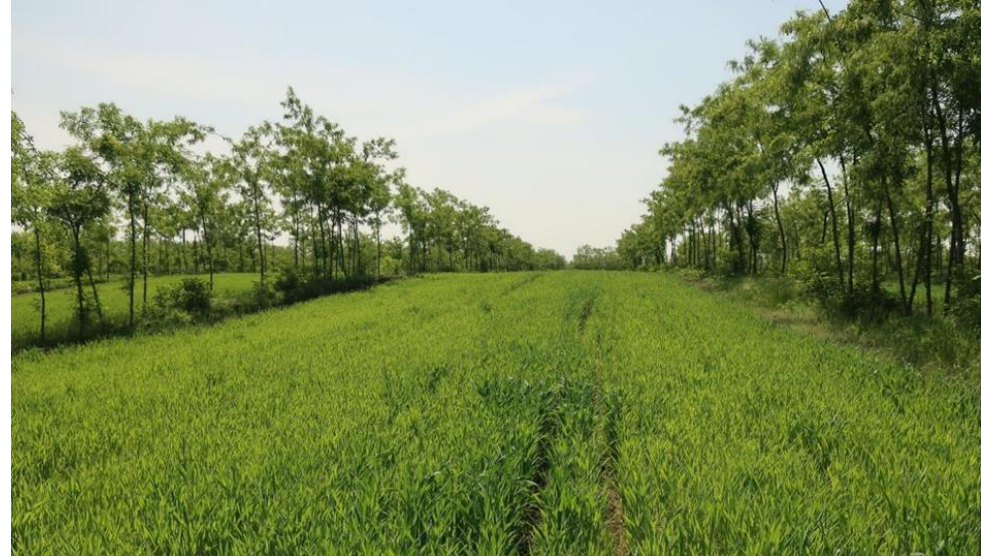
Figure 6. The alley cropping experimental site in Hungary, consisting of black locust ( Robinia pseudoacacia L.) trees and triticale (x Triticosecale W.). (Photo: Veronika Honfy).